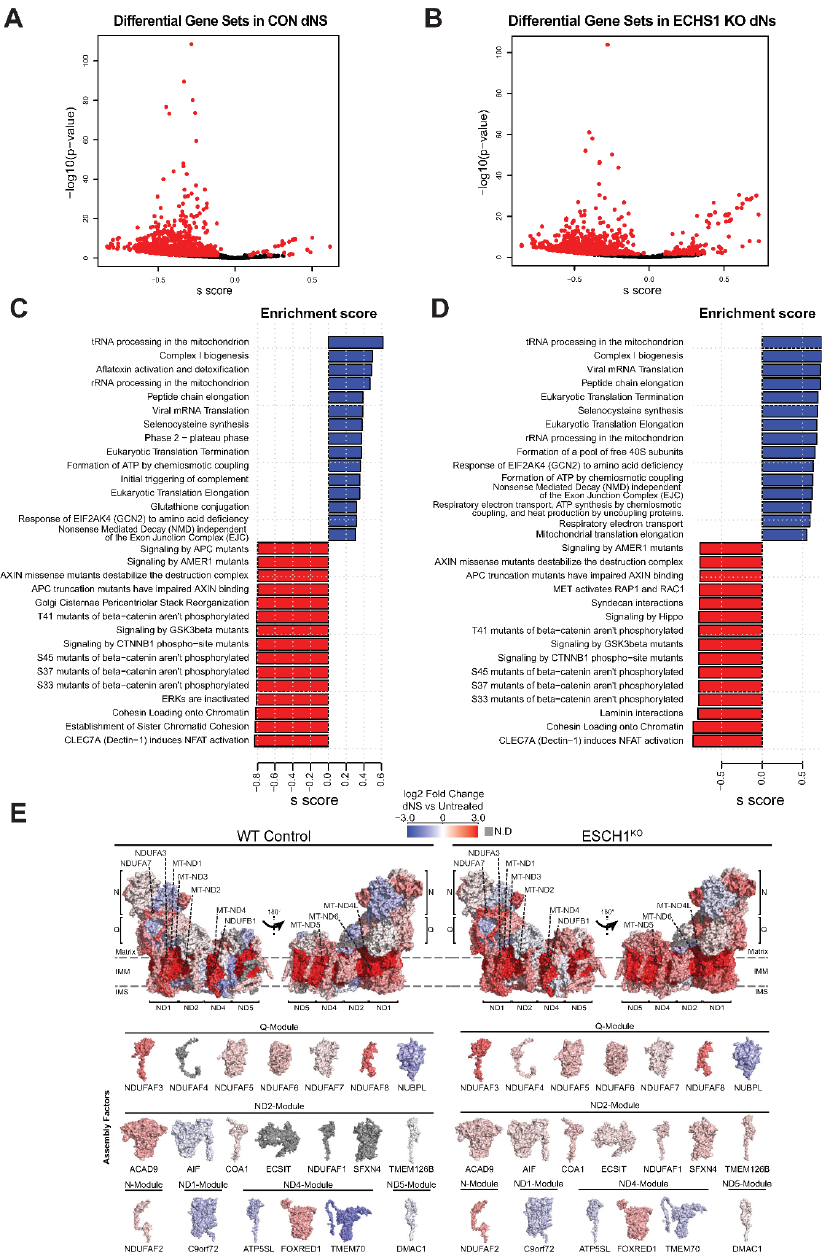
Figure 2. dNs treatment alters the gene expression of multiple cellular process and increases complex I biogenesis. Volcano plot depicting gene expression changes in ( A ) CON cells or ( B ) ECHS1 KO cells following dNs treatment. 1483 gene sets were identified in CON cells, with 34 upregulated and 895 downregulated after dNs treatment (shown in red, FDR < 0.05). Similarly, 1479 gene sets were identified in ECHS1 KO cells, with 147 upregulated and 630 downregulated (shown in red, FDR < 0.05). ( C ) Bar plot of the top 15 upregulated and downregulated gene sets in CON cells due to dNs treatment, as ranked by effect size (s.dist). ( D ) Bar plot of the top 15 upregulated and downregulated gene sets in ECHS1 KO cells due to dNs treatment, as ranked by effect size (s.dist). ( E ) Topographical heatmaps showing RNA-Seq log 2 fold-changes mapped onto the structures of complex I subunits and assembly factors for CON (left) and ESCH1 KO (right) cells treated with deoxyribonucleosides (dNs) relative to untreated cells. Complex I assembly factors are grouped according to the complex I module they are primarily involved with. Grey subunits were not detected